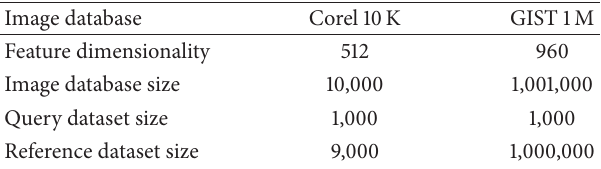
Table 1: Statistics of test dataset.